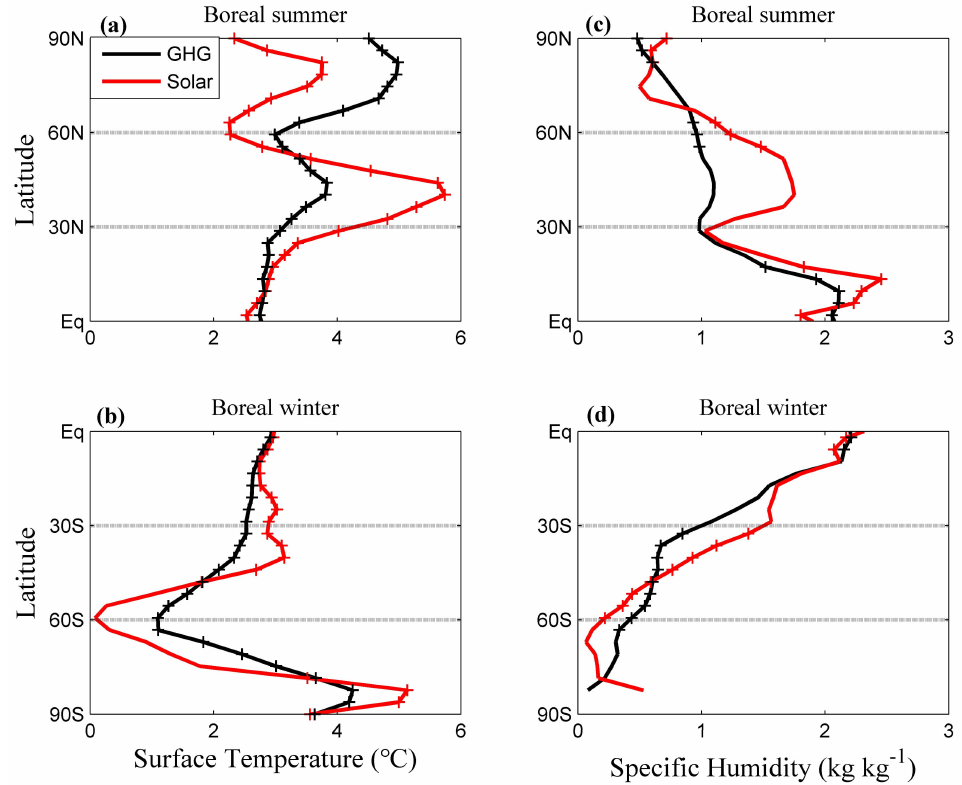
Figure 6. Meridional distributions of temperature and moisture change. Shown are zonal-mean changes of surface temperature (left panel) and moisture (right panel) in boreal summer ( a , c ) and boreal winter ( b,d ) under GHG (black) or solar (red) forcing. Each curve is scaled to have the same global-mean temperature anomaly (PWP minus LIA) as the full forcing. Statistically significant (10% significance level) based on t -test are indicated by